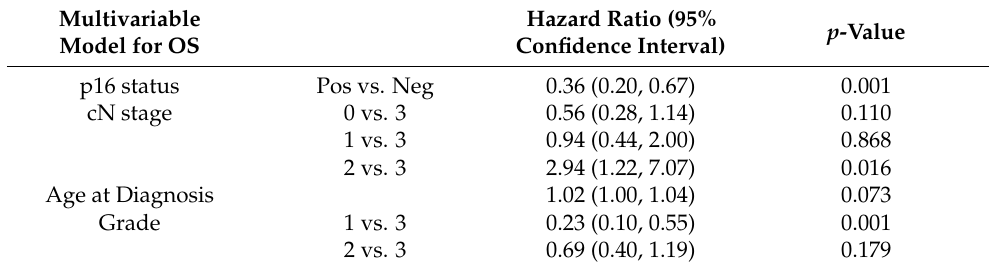
Table 4. Multivariable Model for OS. p16 status is statistically significant in model.